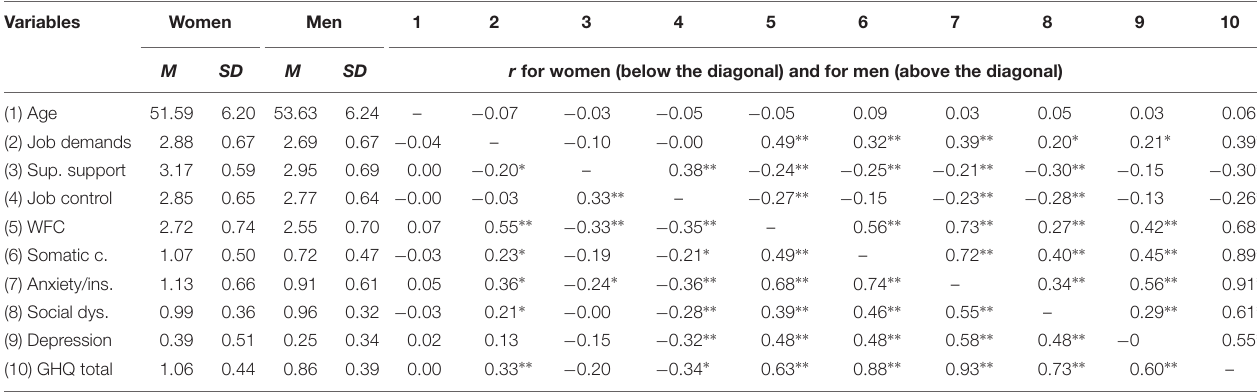
TABLE 2 | Means, standard deviations, and correlation matrix obtained separately for women ( n = 100) and men ( n = 154) samples.